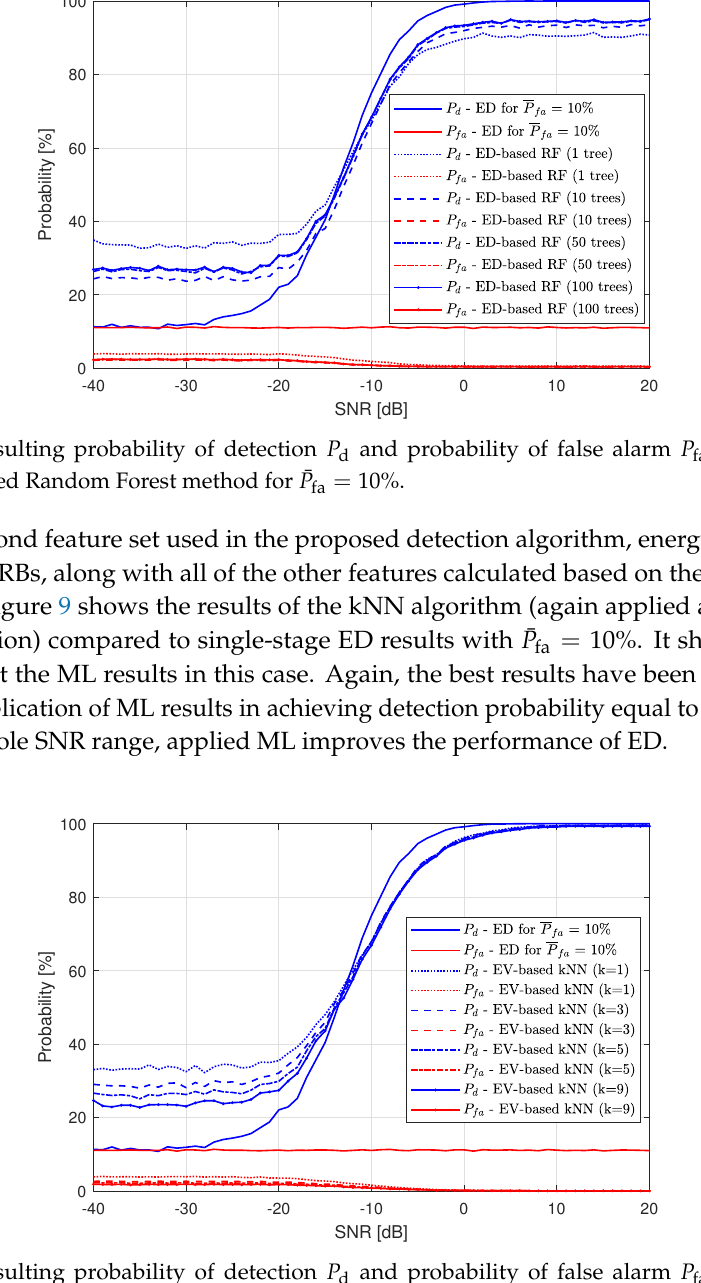
Figure 9. Resulting probability of detection P d and probability of false alarm P fa of the Energy Vector-based k-Nearest Neighbors method for ¯ P fa =